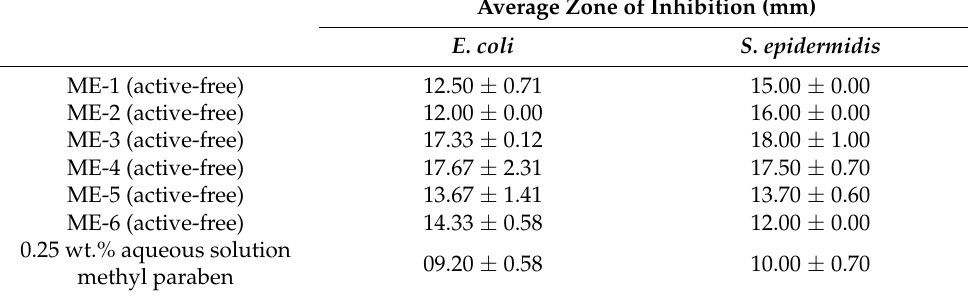
Table 6. Zone of inhibition (mm) of active-free microemulsions against E. coli and S. epidermidis . Data represent the mean ± SD (n =